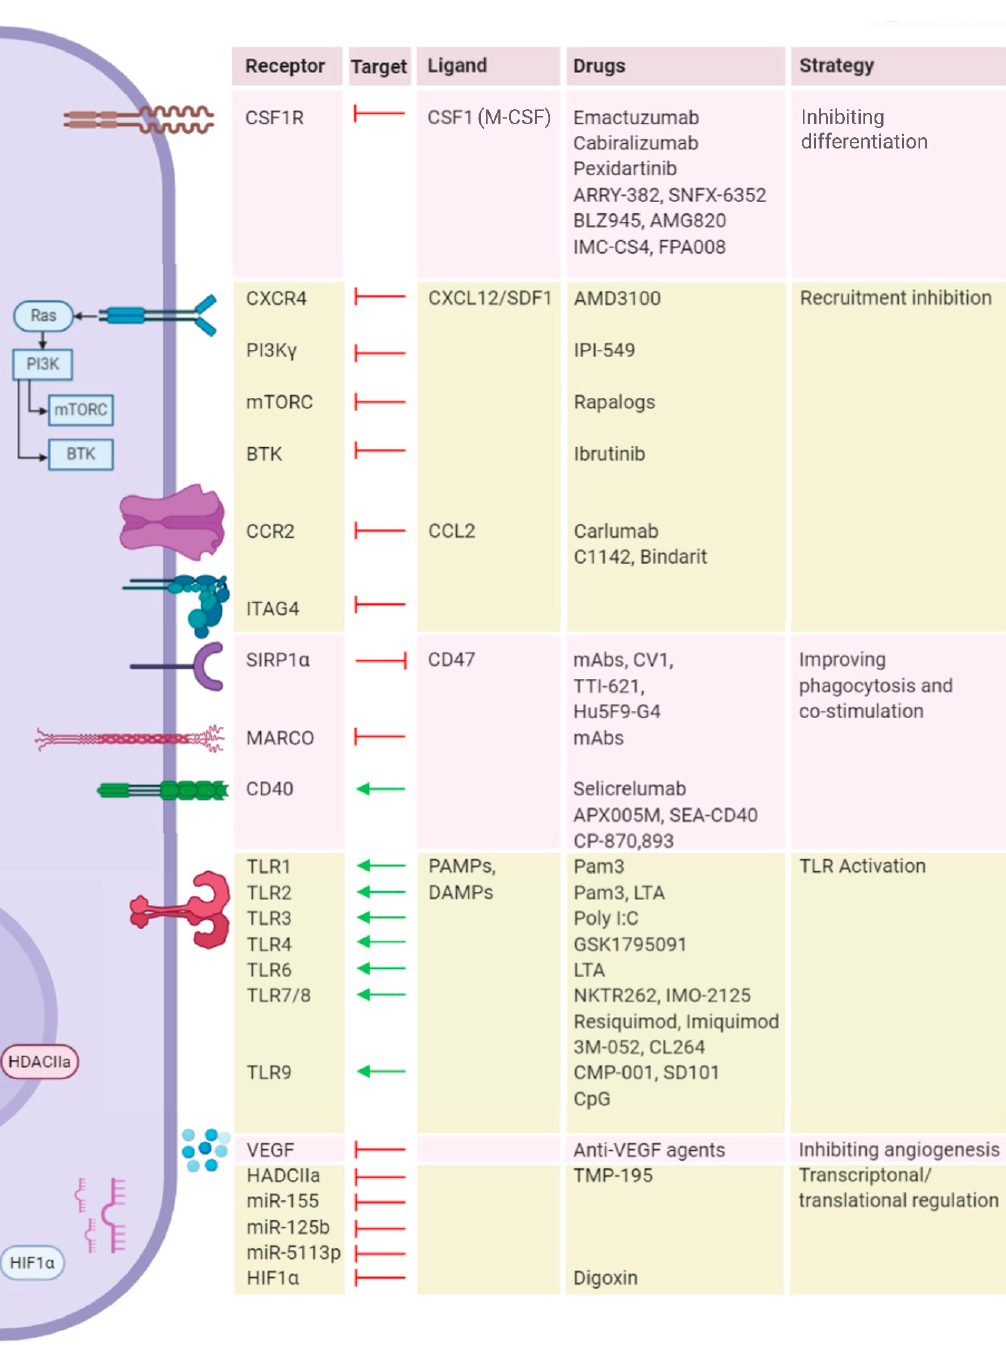
Figure 3. Current landscape of macrophage repolarization strategies. Various receptors, secretory molecules and regulatory pathways that skew macrophages to M2 state are lined on the left, and the respective therapeutic targets, their ligands, targeting strategies, and therapeutic agents are listed in the corresponding table on the right. Abbreviations: CSF1R: Colony-stimulating factor 1 receptor; CSF1: Colony-stimulating factor 1; M-CSF: Macrophage colony-stimulating factor; CXCR4: C-X-C chemokine receptor type 4; CXCL12: C-X-C motif chemokine ligand 12; SDF1: stromal cell-derived factor 1 (SDF1); PI3K: Phosphoinositide 3-kinase; mTORC: Mammalian target of rapamycin complex; BTK: Bruton’s tyrosine kinase; CCR2: C-C chemokine receptor type 2; CCL2: C-C Motif chemokine ligand 2; ITAG: Integrin alpha gamma; SIRP1 α : signal regulatory protein alpha; MARCO: Macrophage receptor with collagenous structure; TLR: Toll-like receptor; CD: Cluster of differentiation; PAMPs: Pathogen-activated molecular patterns; DAMPs: Damage-associated molecular patterns; VEGF: Vascular endothelial growth factor; HDACIIa: Histone deacetylase class IIa; HIF1 α : Hypoxia-inducible factor